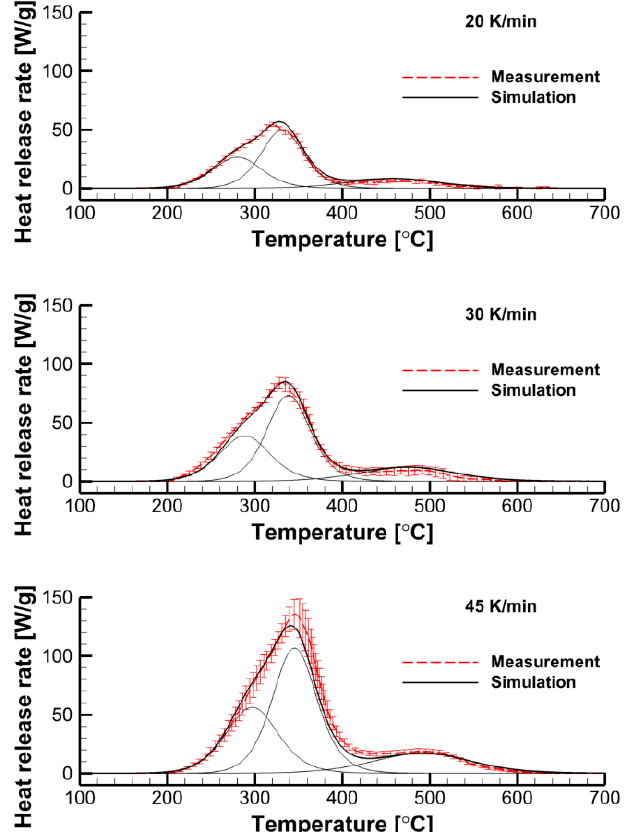
Figure 10. Performance of the three-reaction decomposition model: the simulations are compared with the MCC measurements at three heating rates of 20, 30, and 45 K/min. Thin lines show individual contributions by each reaction.